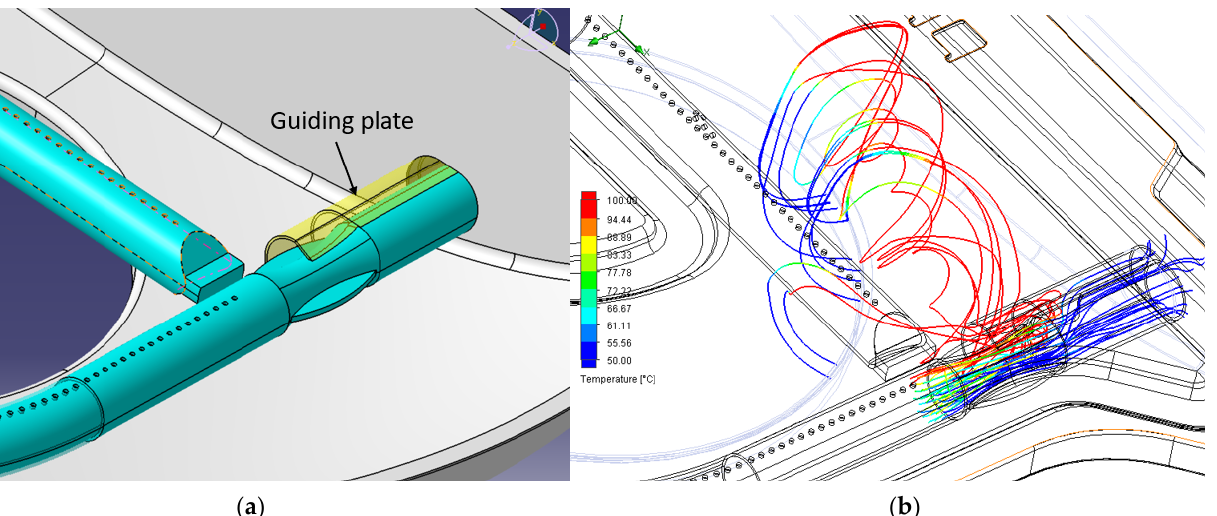
Figure 9. Combustion simulation results of improved design #1.